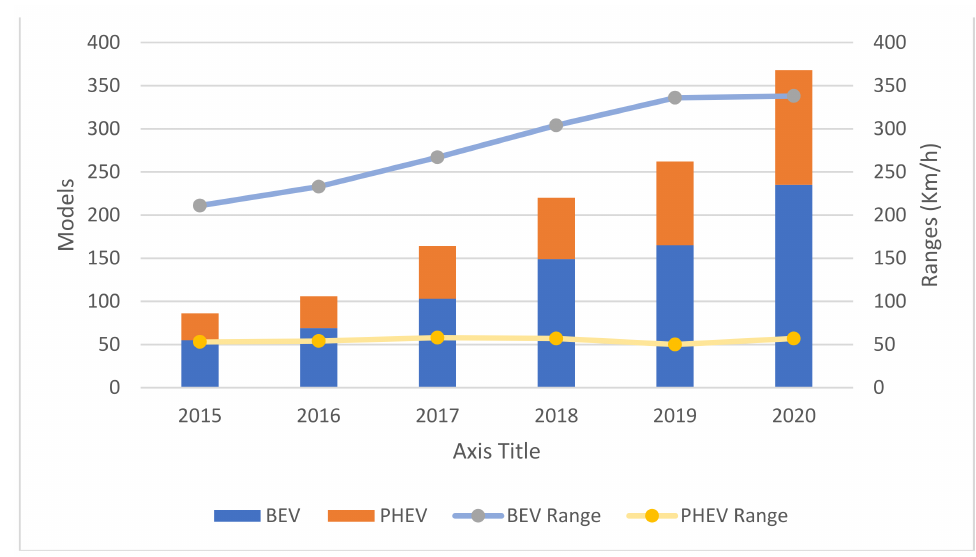
Figure 12. Electric car models available globally and the average range, 2015–2022